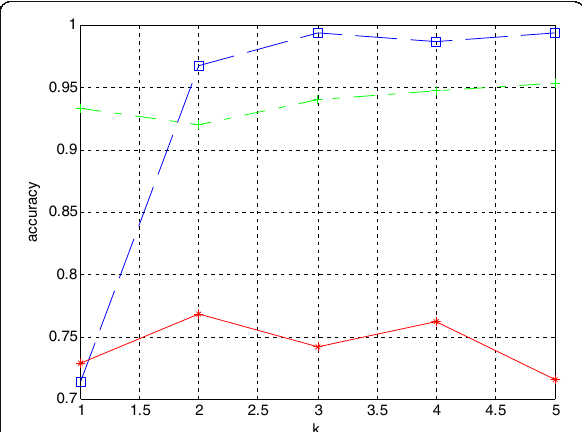
Fig. 3 Accuracy with images of different category background. As shown in the figure, the blue curve denotes the accuracy of the image with the background of the buildings. The green curve denotes the accuracy of the image with the background of the sky, and the red curve denotes the accuracy of the image with the background of the